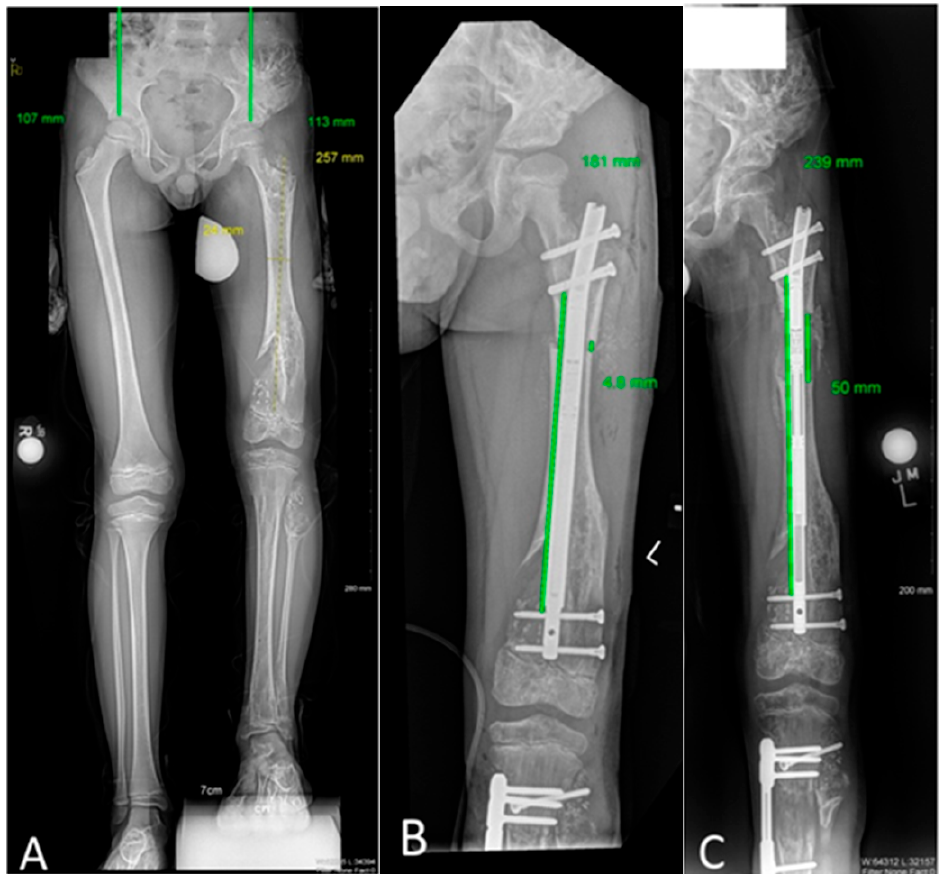
Figure 1. Uncomplicated limb lengthening episode with a motorized intramedullary nail for a patient with enchondromatosis. This figure portrays Patient 6’s lengthening experience. A 9-year-old male with Ollier’s disease affecting his left femur (proximal and distal metaphyseal), tibia (proximal metaphyseal), and fibula (head-neck region). ( A ) The patient had an initial right > left leg length difference of 76 mm. ( B ) He was managed with left femur osteotomy and implantable lengthening nail. The proximal and distal cross-locking screws were placed intralesionally. He also had ipsilateral tibia osteotomy and lengthening with a implantable lengthening plate, which is not the focus of the current manuscript. ( C ) After 75 days, the femur nail had achieved its maximum excursion (50 mm) with corresponding increase in the femur osteotomy gap. Appropriate early regenerate can be observed. This patient had an uncomplicated lengthening experience and is currently consolidating the femur, tibia, and fibula sites.